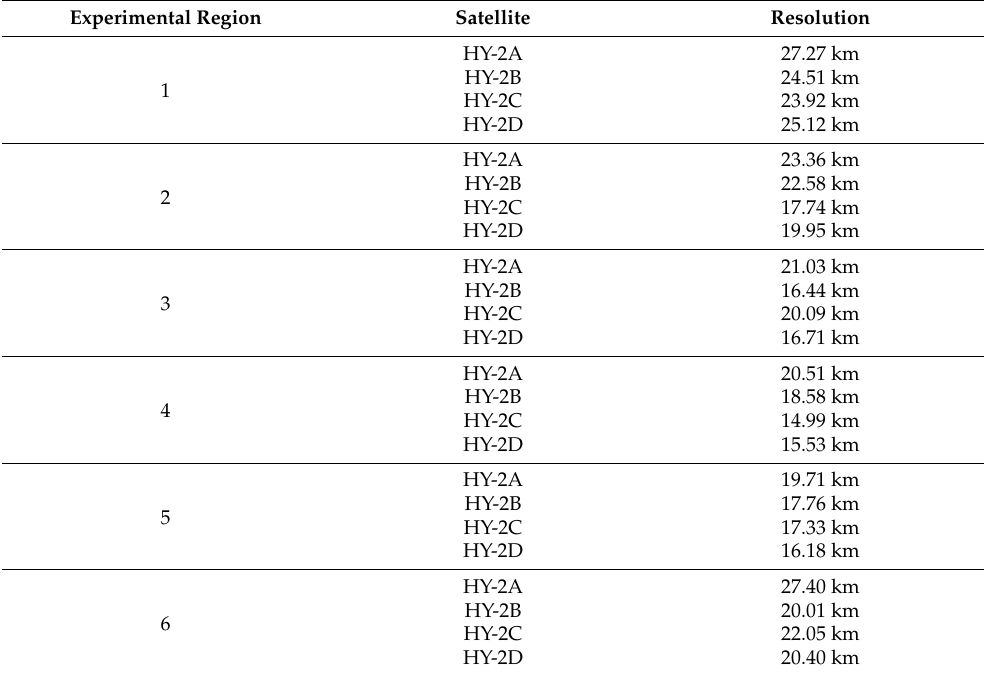
Figure 6. Coherence map and deduced resolution capabilities of repeat track data sequences for HY-2A, HY-2B, HY-2C and HY-2D over study regions: Region 1, North Pacific; Region 2, South Pacific; Region 3, Mid-Pacific; Region 4, Indian Ocean; Region 5, North Atlantic; Region 6, South Atlantic. Table 4. Summary of resolution capabilities for HY-2 data sequences: Region 1, North Pacific; Region 2, South Pacific; Region 3, Mid-Pacific; Region 4, Indian Ocean; Region 5, North Atlantic; Region 6, South Atlantic.